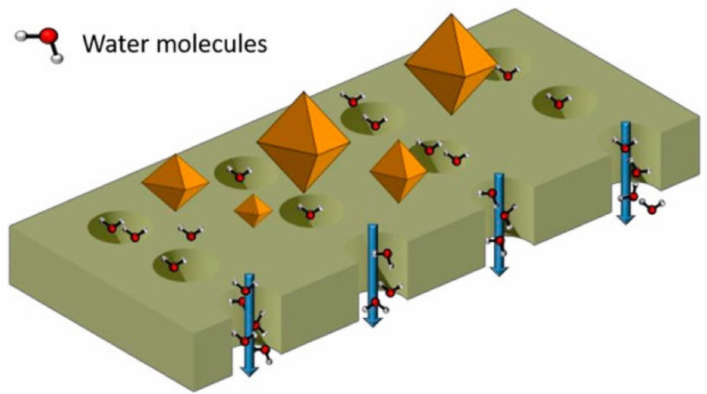
Figure 3. Membrane-assisted crystallisation principle. Protein and stripping solution are on different sides of the membrane. The volatile solvent is removed from the protein solution in the vapour phase; supersaturation is reached, and crystals form. Reprinted with permission from Polino et al. [145]. Copyright 2019, American Chemical